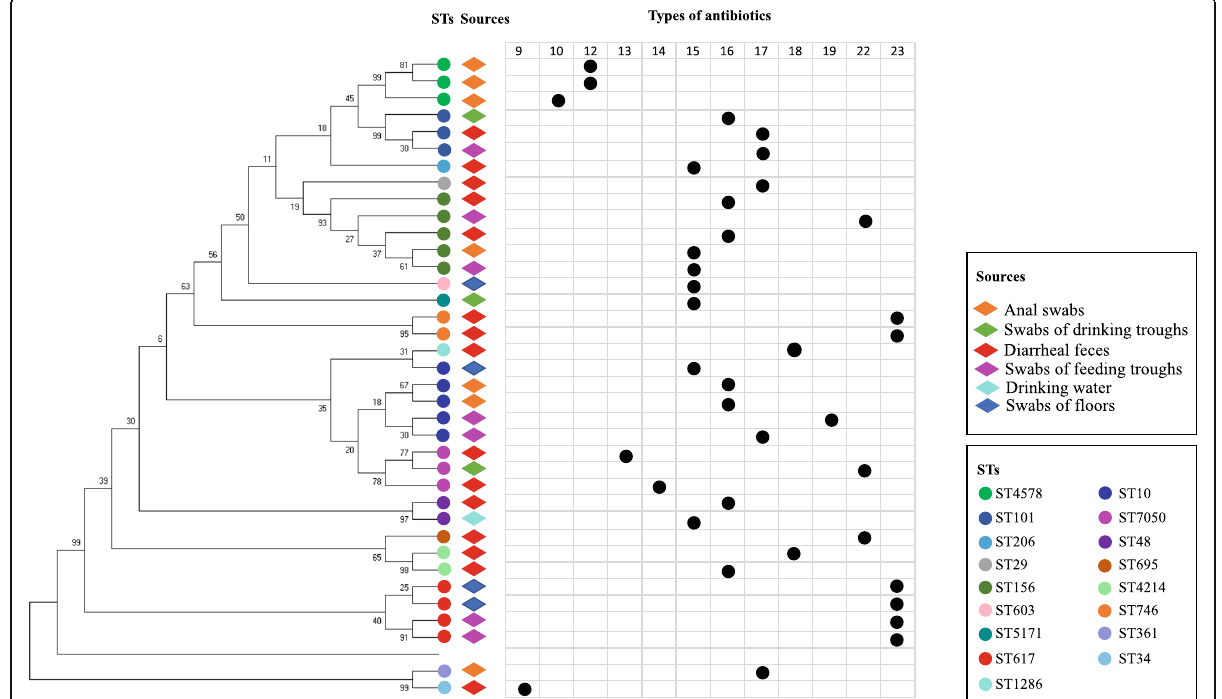
Fig. 4 Sequence types of mcr -positive E. coli isolates. The left panel shows a phylogenetic tree constructed based on the multilocus sequence typing (MLST) data, and the right panel shows the numbers of antibiotics that each isolate resists